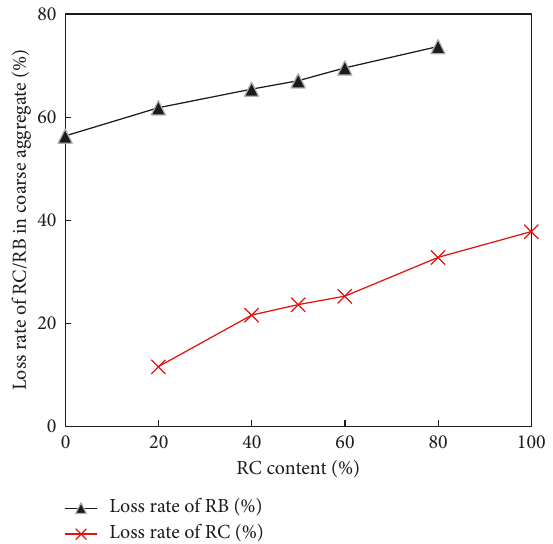
Figure 5: Content of recycled concrete before crushing and loss rate of recycled clay brick/concrete in crushed coarse aggregates.